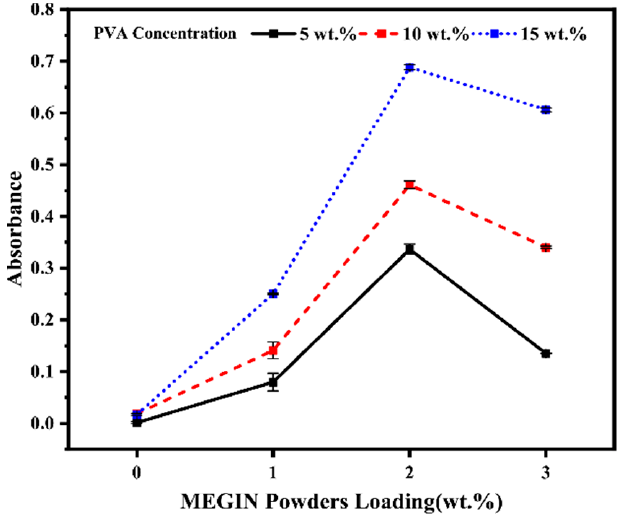
Figure 2. Absorbance of Gr/PVA impregnation mixture. At the same PVA concentration, the effect of Gr/PVA ratio on the absorbance of Gr/PVA mixture has been investigated in MEGIN powders loading ranging from 0 to 3 wt.%. It has been observed that with an increase of MEGIN, the absorbance value increases stably at first. The rate becomes faster when MEGIN powders loading increases until attaining the maximum value at 2 wt.%. Afterwards, the absorbance value decreases with a further increase in MEGIN concentration. Due to the addition of MGEIN, the color of the impregnation mixture continues deepening. Therefore, the absorbance value increases constantly. However, it is difficult for PVA to suppress the Van der Waals force between many graphene sheets when the MEGIN concentration becomes higher. As a consequence, the graphene agglomerates, which result in the decrease of the absorbance value. At the same MGEIN addition, the absorbance values of all the impregnation mixtures increased together with the increase of PVA. The optimum value was obtained for 2 wt.% PVA concentration. Compared with pure PVA solution, the absorbance values of 2 wt.% MGEIN addition in 5, 10, and 15 wt.% PVA solution increase by 20, 28, and 42 times, respectively, indicating that MGEIN disperses better in the solution with a higher PVA concentration. According to the Rayleigh formula, the absorbance value is proportional to the con- centration of particles in the suspension. The larger the absorbance value, the better the dispersion of the impregnation mixture. Therefore, under different MGEIN addition, the absorbance value at 5 wt.% PVA concentration is the lowest, indicating that MGEIN has the worst dispersibility at 5 wt.% PVA concentration. Similarly, MGEIN disperses better at 15 wt.% PVA concentration. In addition, the optimum ratio of Gr/PVA impregnation mixture, which has better dispersion, consists of 15 wt.% PVA and 2 wt.%